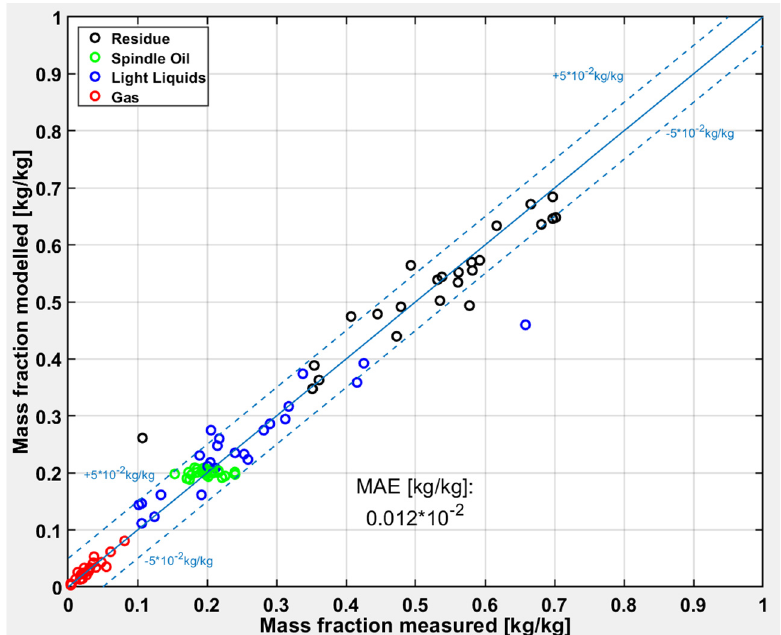
Figure 8. Deviation of the modeled and measured values of the test runs with pure carrier fluid. “MAE” is the mean absolute error of the optimization of 0.01 × 10 − 2 kg/kg. The dashed lines show the 10% deviation.